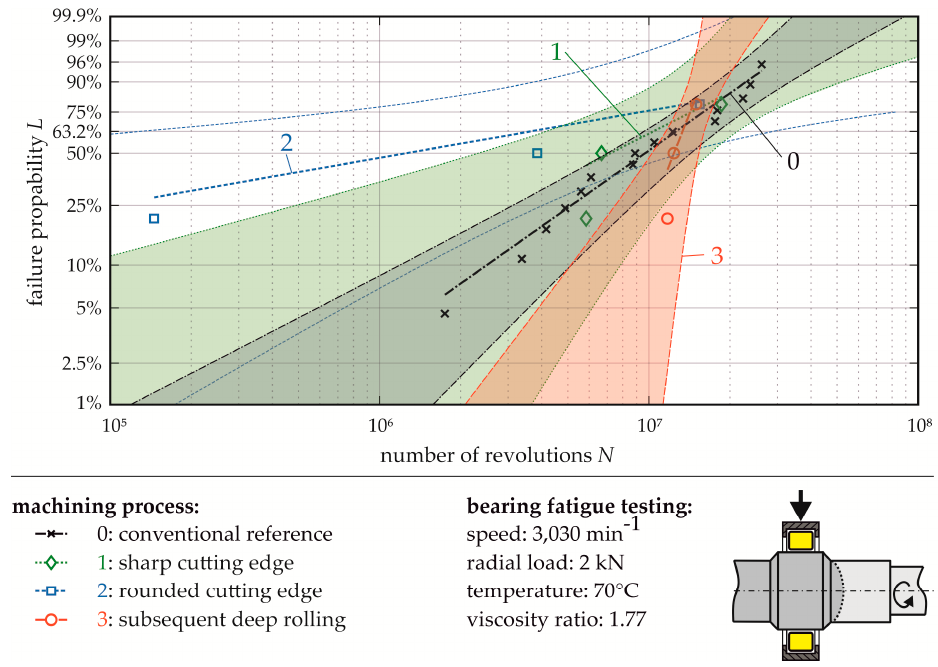
ff erent machining processes.